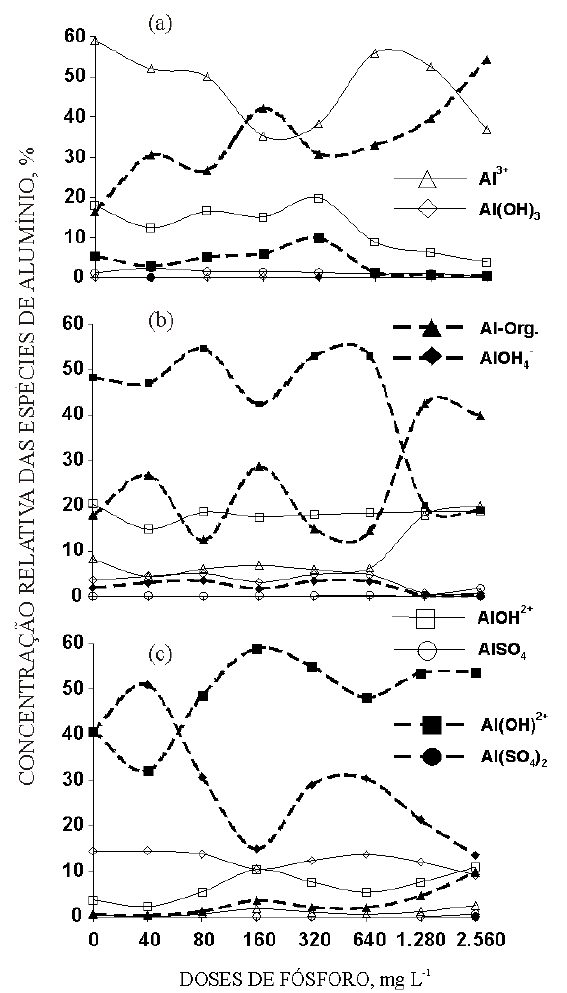
Figura 5. Concentração relativa de espécies de alumínio da solução de um Latossolo Vermelho distrófico típico, cultivado, por sete anos, no sistema plantio direto em diferentes condições de acidez: pH 4,0 (a); pH 4,5 (b) e pH 6,4 (c) e submetidas a aplicação de doses de fósforo.